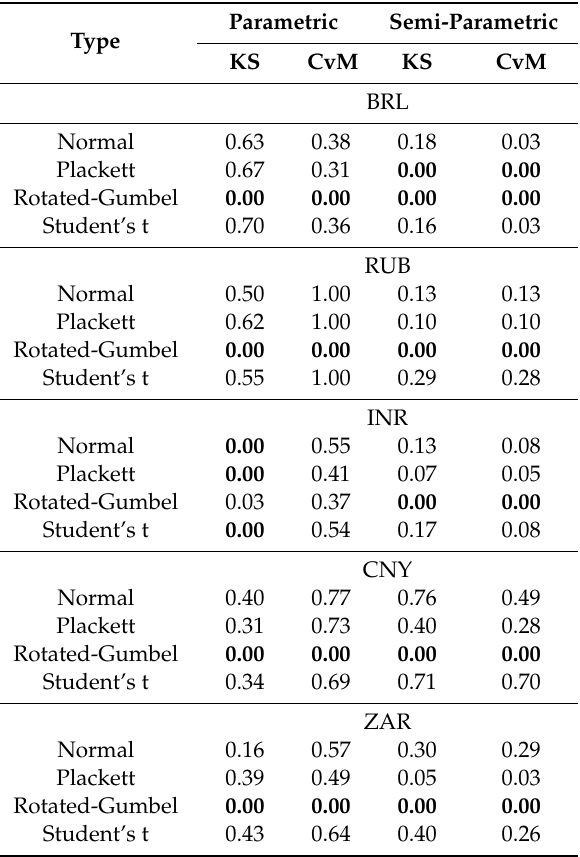
Table 11. Goodness-of-fit test for constant copula models.